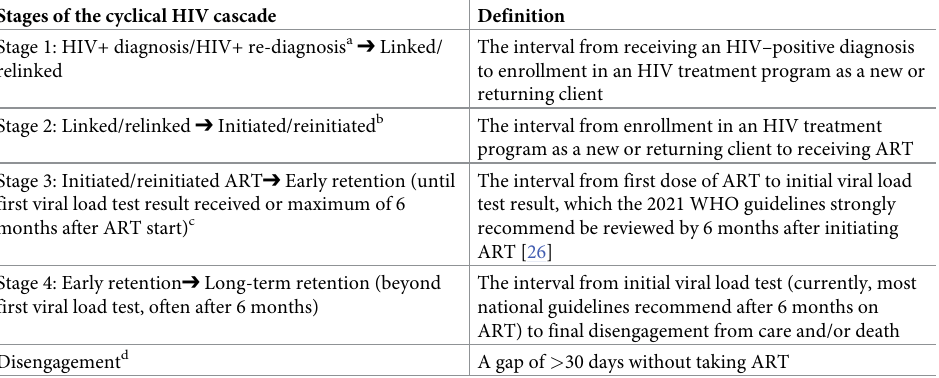
Table 1. Definitions of the stages of the cyclical cascade of HIV care Stages of the cyclical HIV